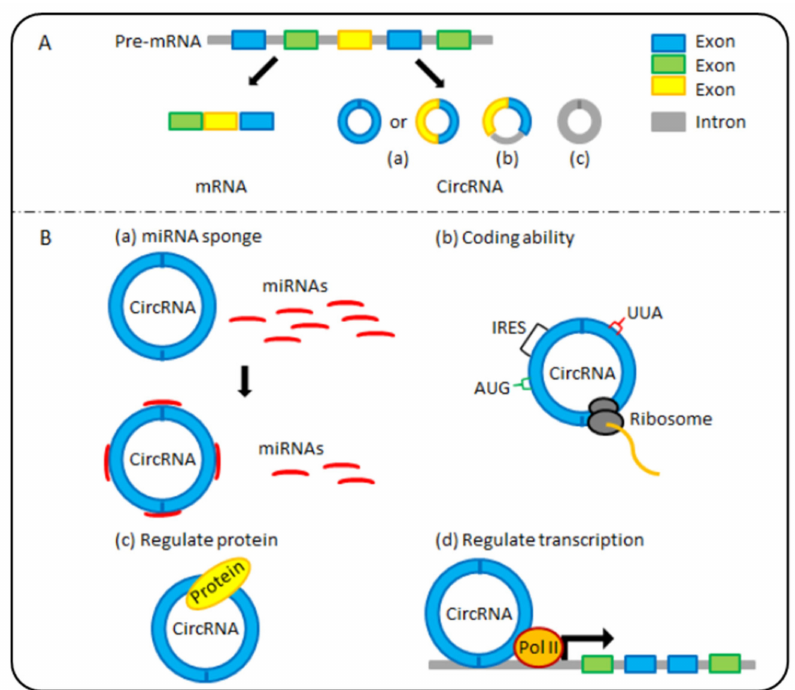
Figure 1. The classification and molecular functions of circular ribonucleic acids (circRNAs). ( A ) According to their sequences, circRNAs are divided into 3 main categories: (a) exonic